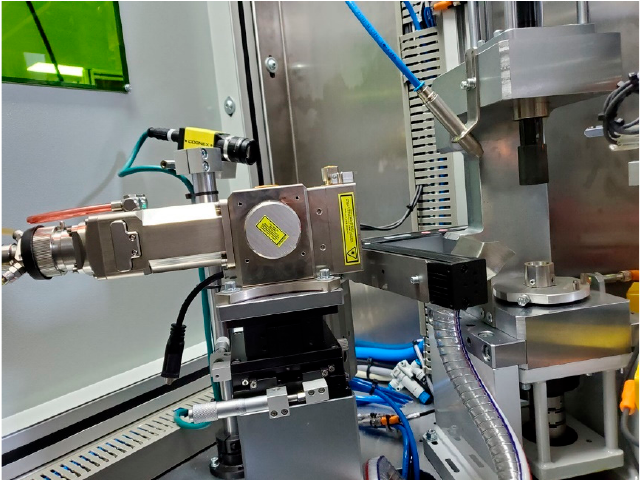
Figure 2. Laser welding system.